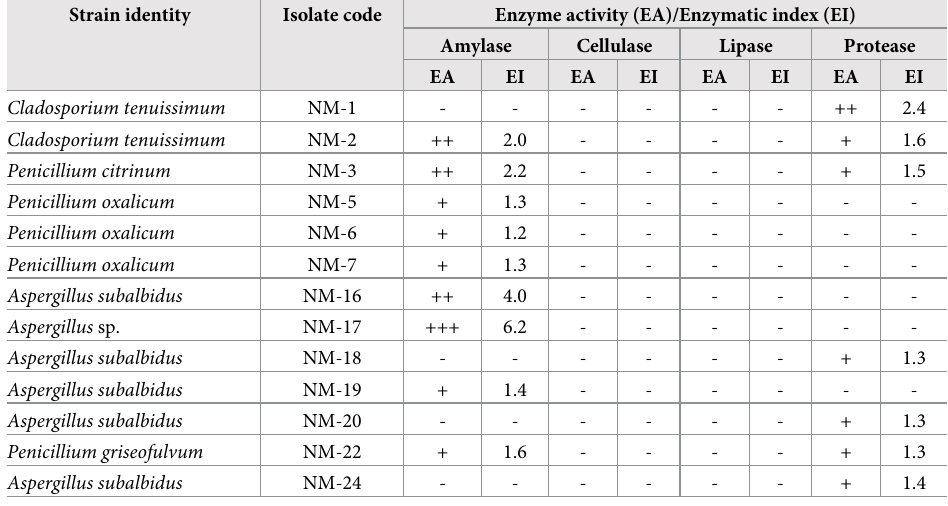
Table 4. Summary of enzymatic activity of some of the studied fungal isolates. Only isolates positive for at least one substrate are shown.